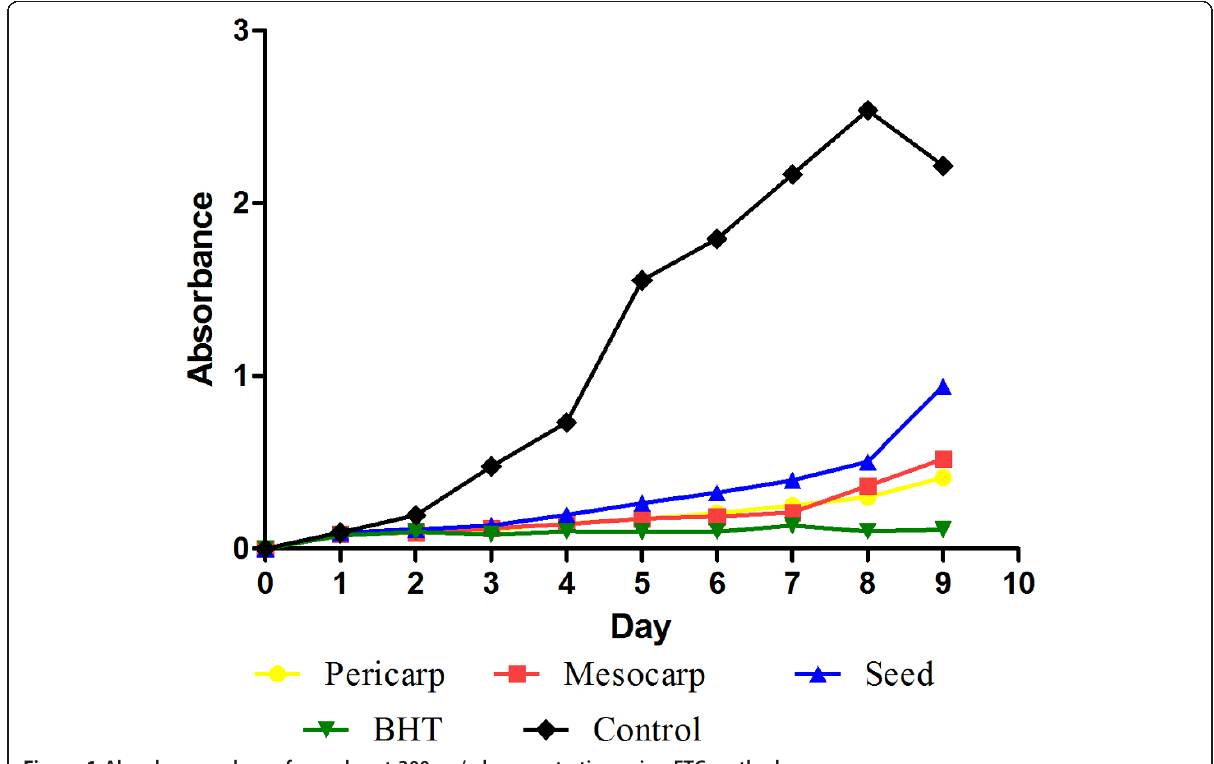
Figure 1 Absorbance values of samples at 300 μ g/ml concentration using FTC method .